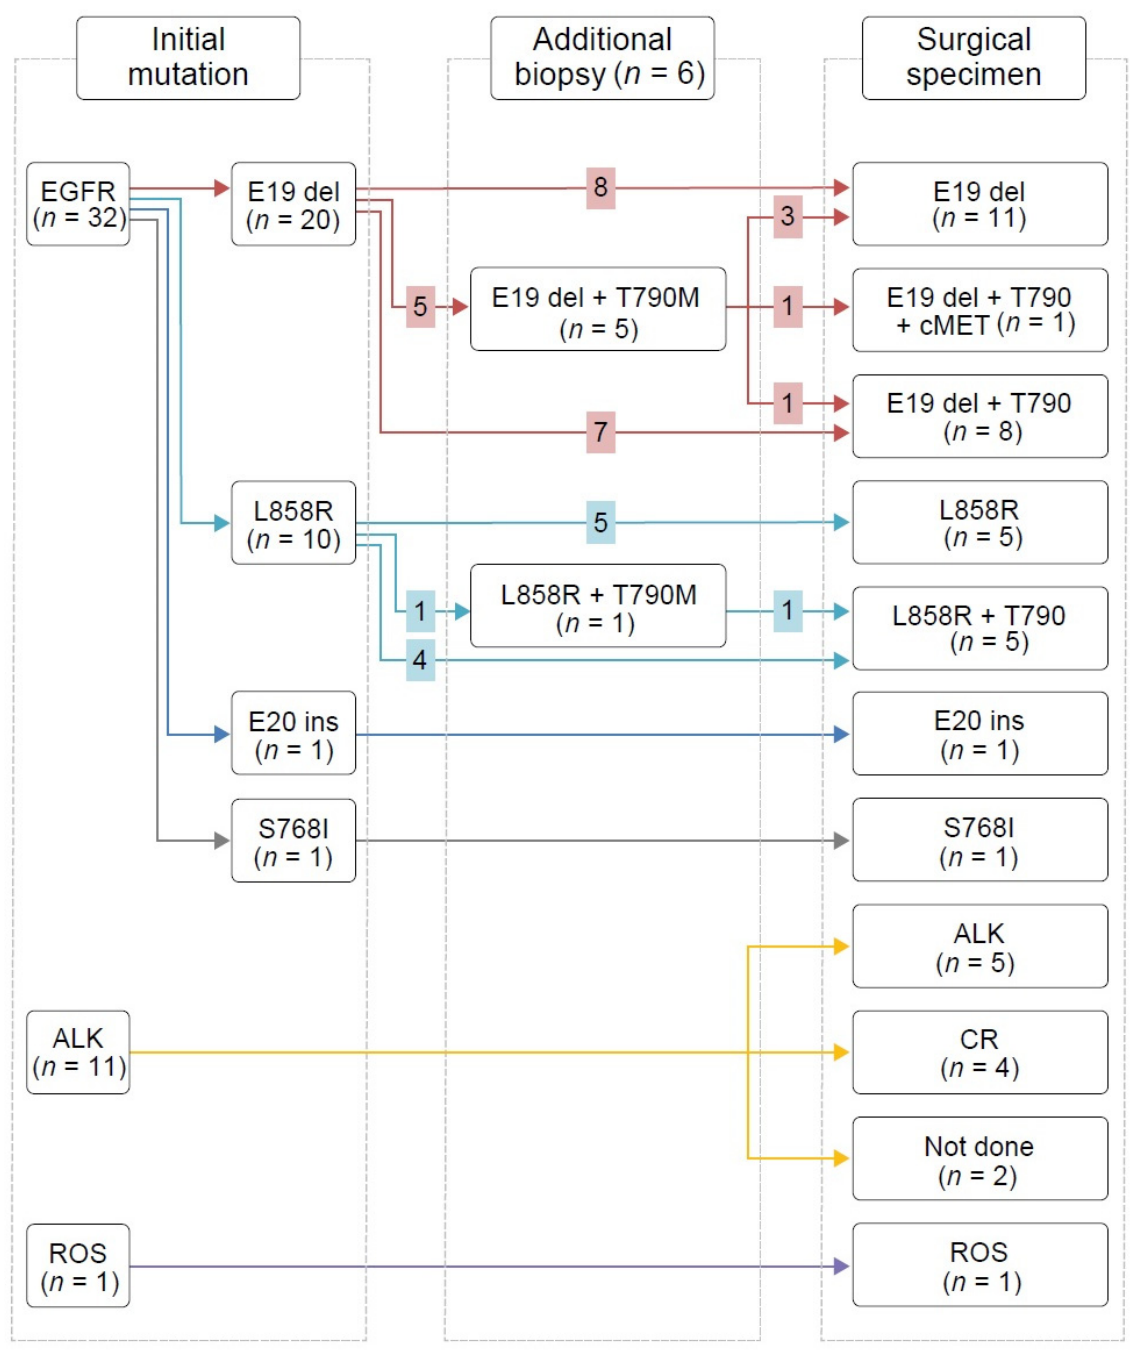
Figure 3. Mutation profile changes.